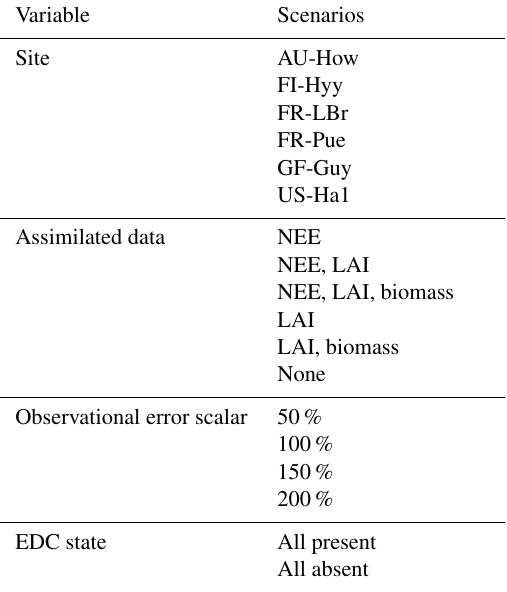
Table 3. Model specifications varied in the factorial experiment. Each of the 16 model versions was run with every combination of scenarios across each variable. Note that observational error scalars were not applied when no data were assimilated into the